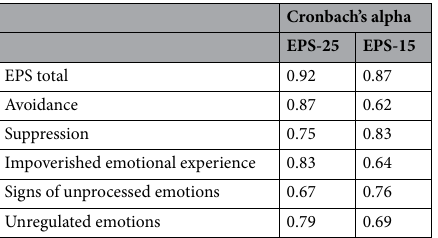
Table 4. Internal consistency for the Swedish validation EPS-25 and EPS-15.